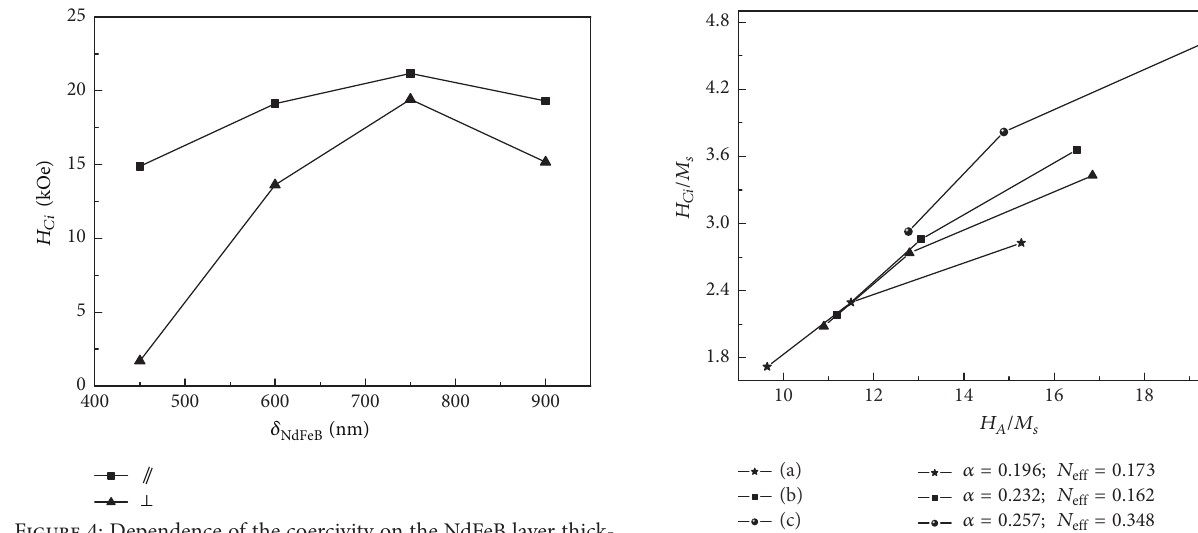
the dependence of 𝐻 𝐶𝑖 / 𝑀 𝑠 on 𝐻 𝐴 /𝑀 𝑠 for Ta/Nd/NdFeB ( 𝑥 nm)/Nd/Ta ( 𝑥 = 450, 600, 750, 900 ) films. The micromag-